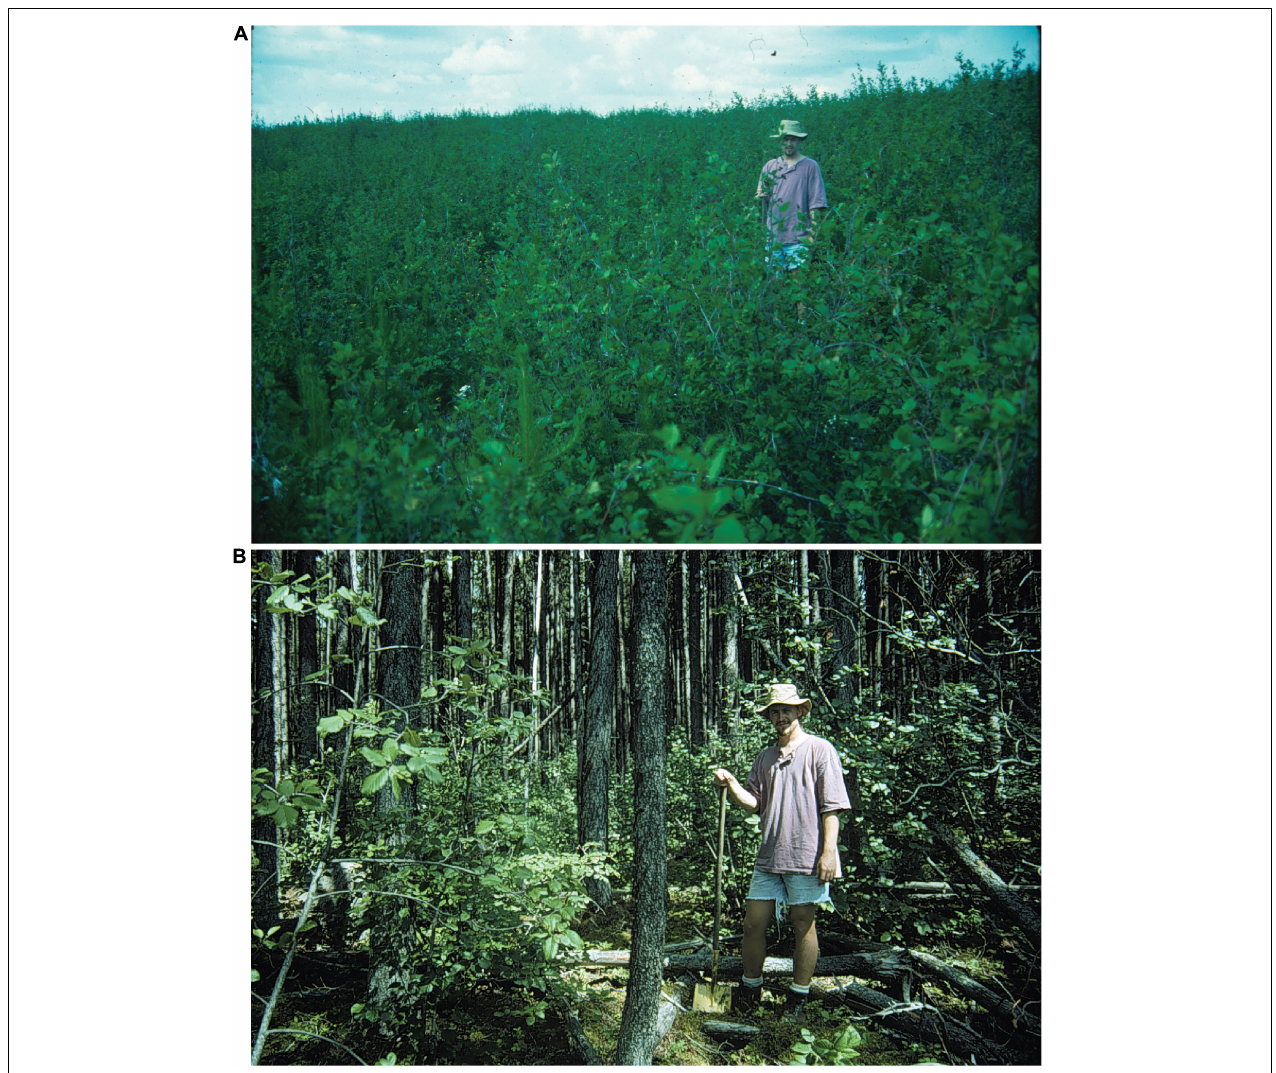
FIGURE 1 | Photographs of stand conditions in 1994, showing (A) dense Sitka alder regeneration at research site, and (B) alder understory below a mature ( ∼ 150 year-old) lodgepole pine canopy approximately 100 m east of research